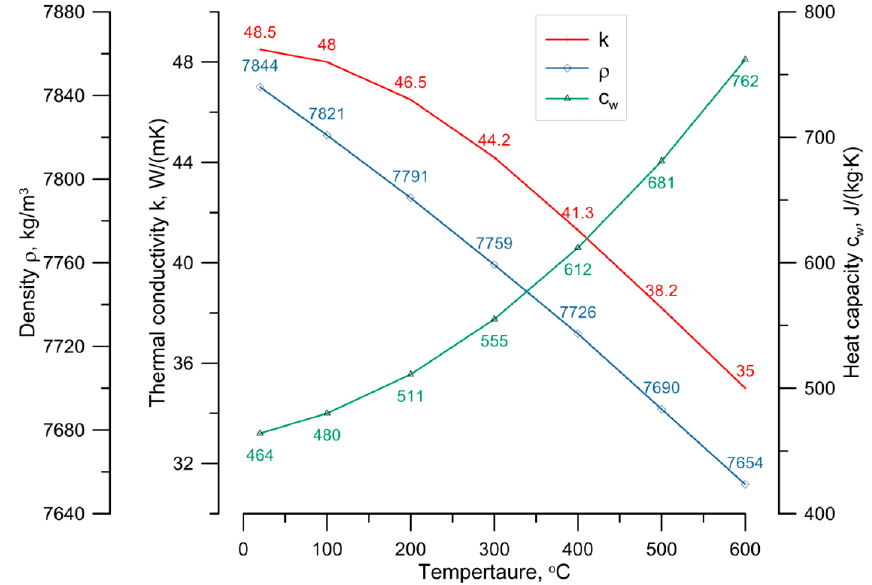
Figure 13. Thermal conductivity values density and heat capacity for steel 14MoV63 as functions of temperature.